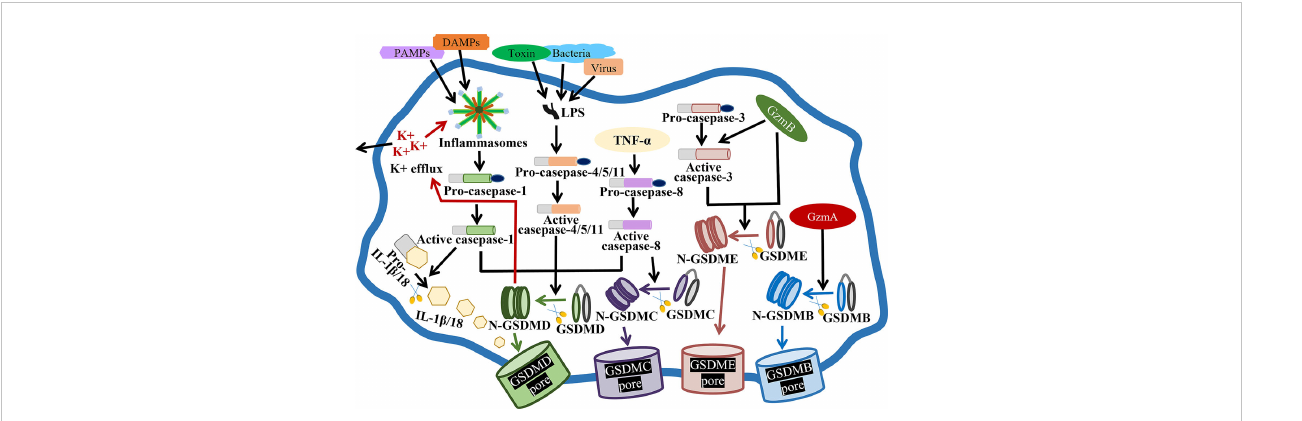
FIGURE 1 Molecular mechanisms of pyroptosis. In the canonical pathway, PAMPs and DAMPs receive intracellular signaling to stimulate in fl ammasomes and active caspase-1. Cleaved-caspase-1 cleaves GSDMD, pro-IL-1 b and pro-IL-18. N-GSDMD perforates the cell membrane by forming nonselective pores, further causing cell lysis and death. In addition, IL-1 b and IL-18 are secreted from the pores formed by N-GSDMD. In the noncanonical pathway, virus, bacteria or toxin-secreted LPS activates caspase-4, -5 and -11, triggering pyroptosis by cleaving GSDMD. In addition, the cleavage of GSDMD results in ef fl ux of K+, ultimately mediating the assembly of NLRP3 in fl ammasome, resulting in the cleavage of pro-IL-1 b and pro-IL-18. In the caspase-3-mediated pathway, active caspase-3 cleaves GSDME to form N-GSDME, inducing pyroptosis. In the caspase-8-mediated pathway, TNF- a treatment induces the activation of caspase-8, which cleaves GSDMD and GSDMC, resulting in pyroptosis. In the granzyme-mediated pathway, released GzmB rapidly activates caspase-3 and GSDME, causing extensive pyroptosis, and GzmB also directly activates GSDME. In addition, GzmA hydrolyzes GSDMB and directly activates